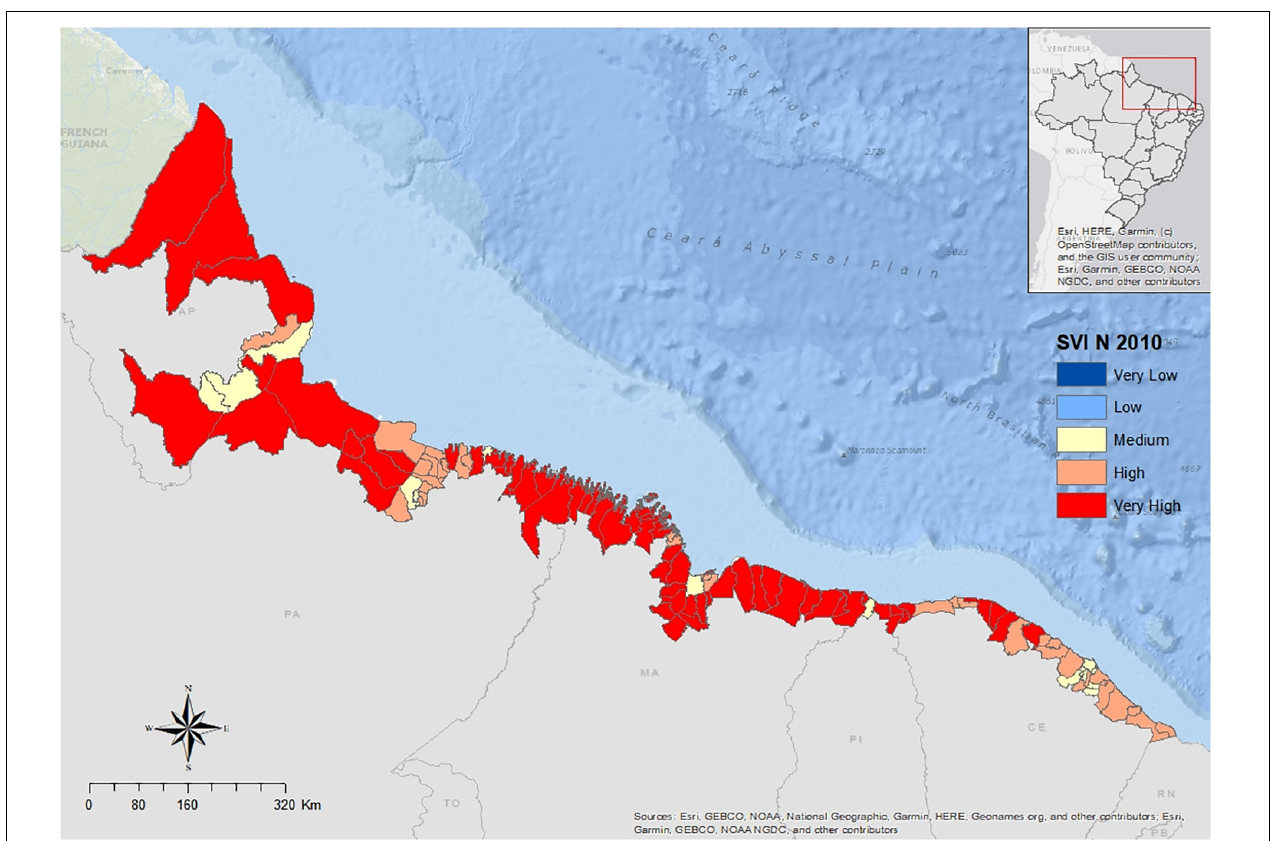
FIGURE 8 | SVI for the North coast municipalities. Elaborated by the authors with data from IPEA